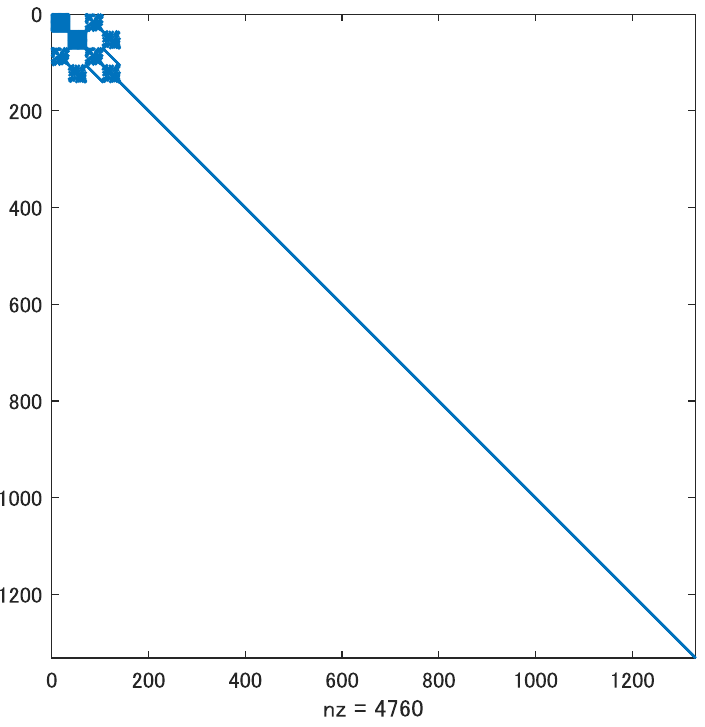
Figure 3. Sparsity pattern of the coefficient matrix after the 1st elimination for SC35.